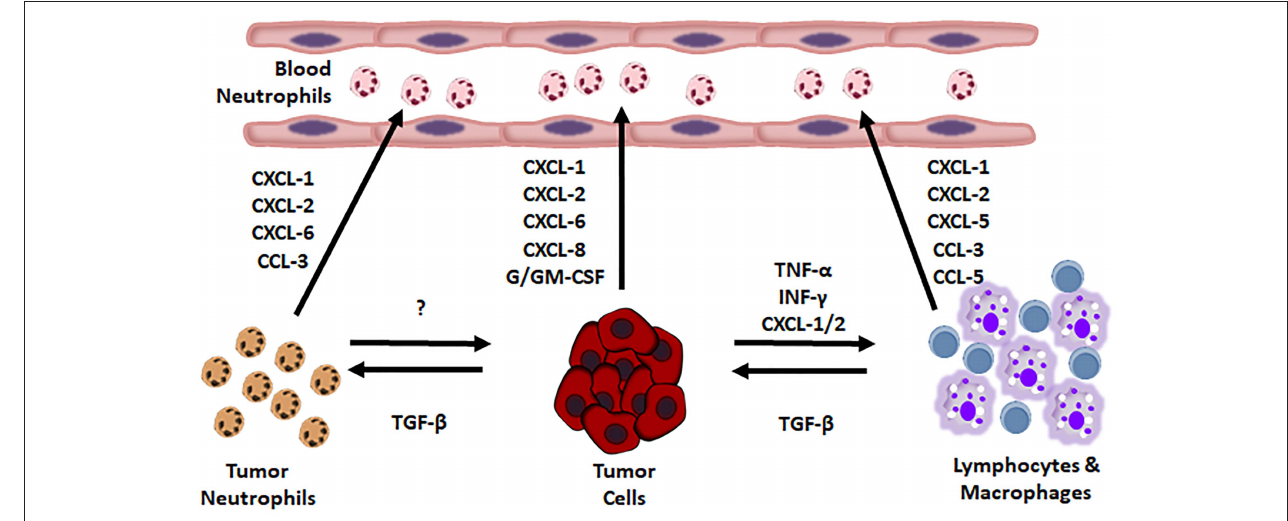
FIGURE 1 | Soluble factors promoting neutrophil recruitment into the